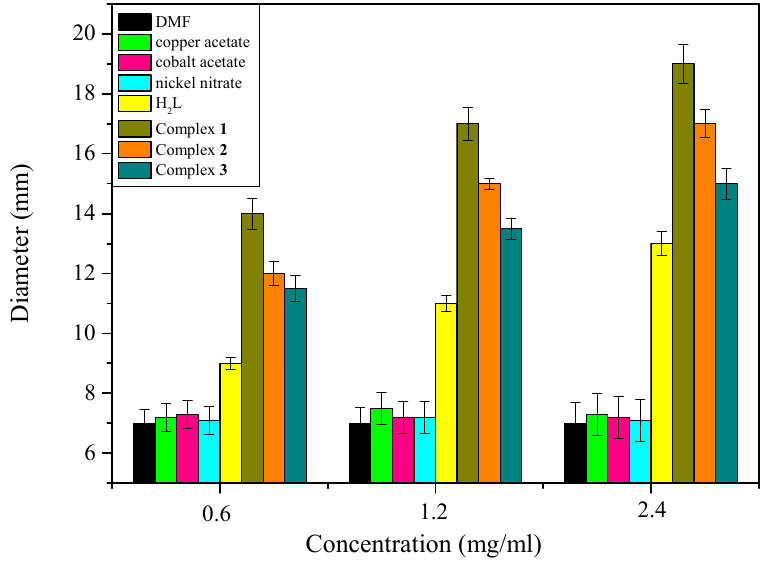
Figure 14. The diameter of inhibition zones of E. coli in different concentrations.